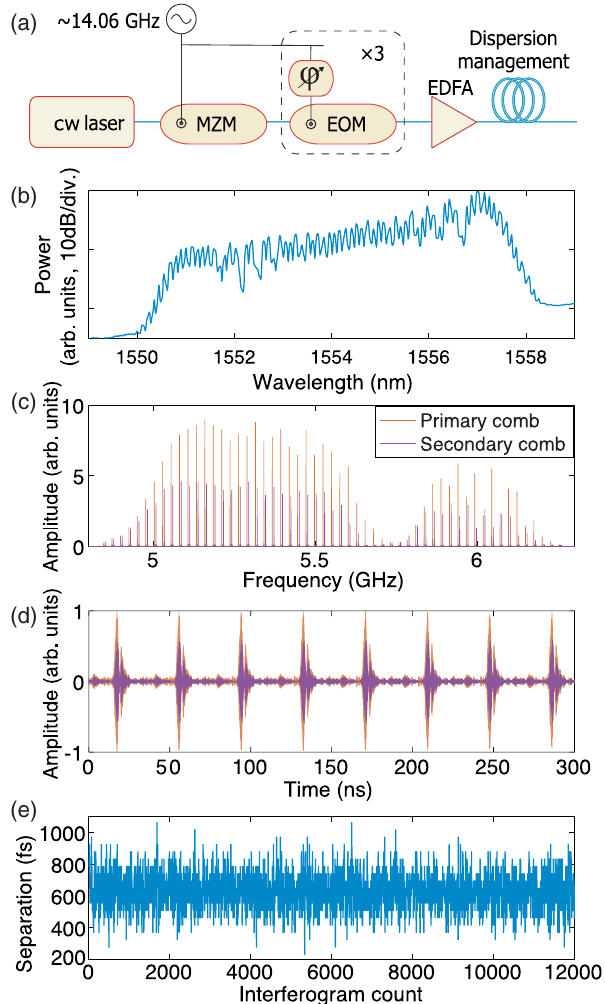
FIG. 8. Electro-optic sampling of solitons. (a) Scheme of the electro-optic comb generation. MZM: Mach-Zehnder modulator. (b) The optical spectrum of the electro-optic comb after amplifi- cation. (c) The spectra of the interferograms corresponding to the primary DKS and the secondary DKS, respectively. (d) The reconstructed interferograms with a temporal length of 300 ns. The relative amplitudes of the interferograms are adjusted in order to clearly show both the interferogram trains. (e) The measured 1 . 2 × 10 4 intersoliton separations, whose averaged value of 629 fs is shown in Fig. 3(b).